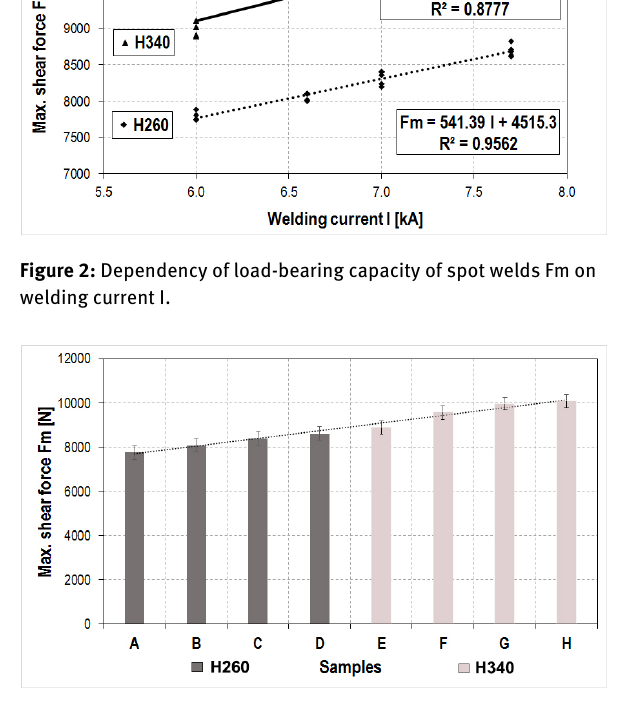
Figure 3: Average values of load-bearing capacities of welded joints.